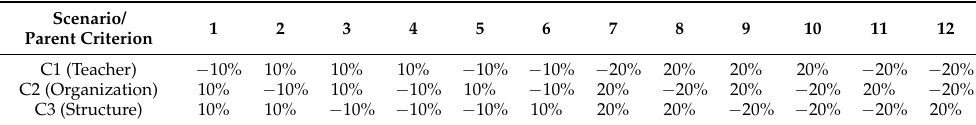
Table 9. Increase in the percentage of each parent criterion in all the simulated scenarios for the sensitivity analysis.